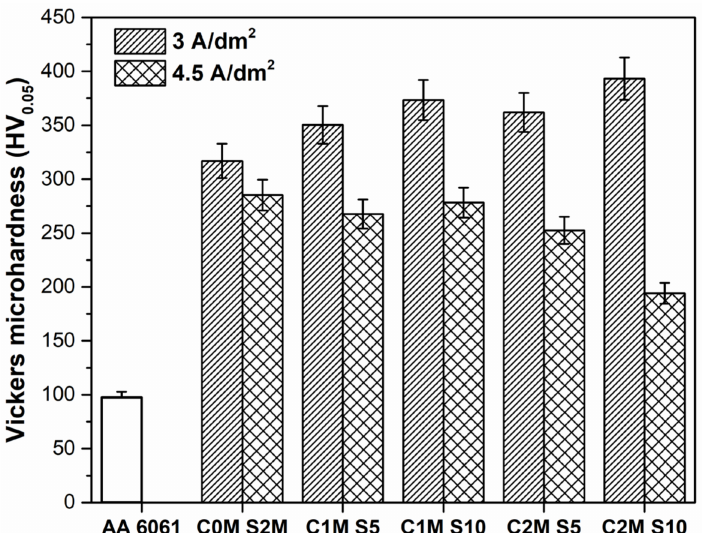
Figure 6. Vickers microhardness of non-anodized AA6061 substrate and after hard anodizing with different solutions a current